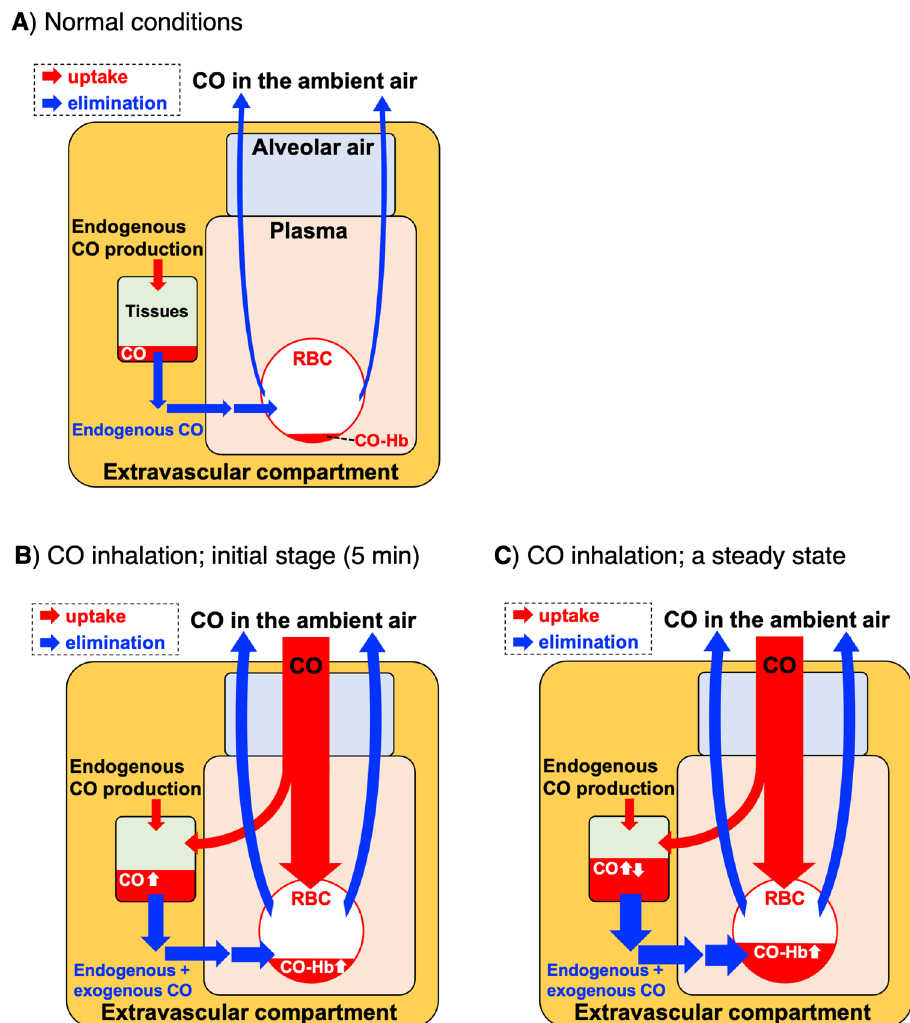
Fig. 8 Proposed mechanism of CO compartmentalization under normal conditions and during CO inhalation. A Normal conditions. Endogenous CO continuously produced in cells is stored in tissues, diffuses to Hb, and is exhaled. B Initial stage of CO inhalation. Inhaled CO forms CO-Hb in RBC and diffused to tissues. C A steady state during CO inhalation. CO accumulated in tissues gradually transfers to Hb in RBC based on the higher CO af fi nity of Hb versus intracellular CO targets (see Table 1 and text for details). The compartment models are based on our data and Refs. 9,19